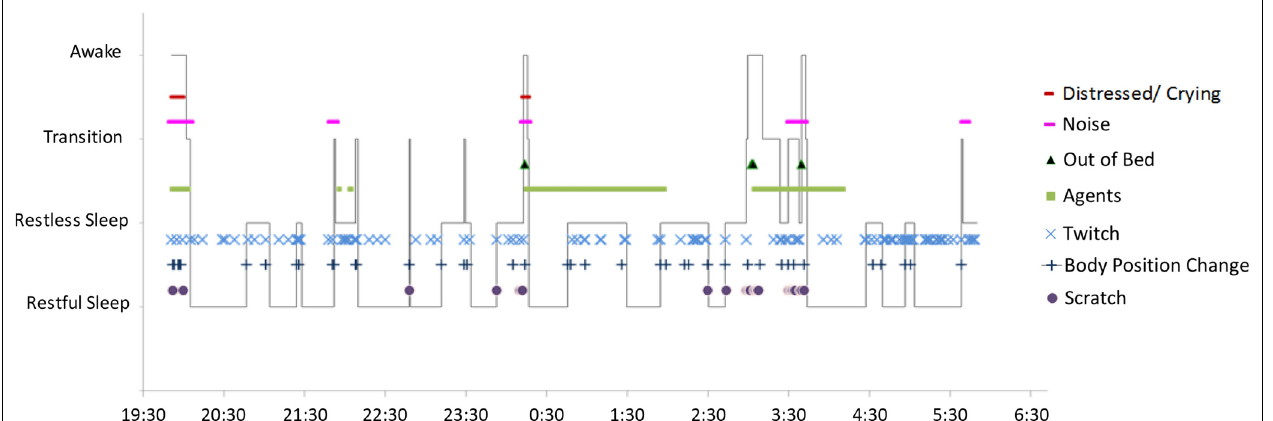
FIGURE 5 | HVS-hypnogram . This diagram shows the final hypnogram resulting from analysis and annotation of the case vignette HVS-recording. Time is displayed on the horizontal axis (total period of one night); sleep state (indicated by the solid black line) is displayed on the vertical axis. Sleep events are labeled according to the embedded legend.